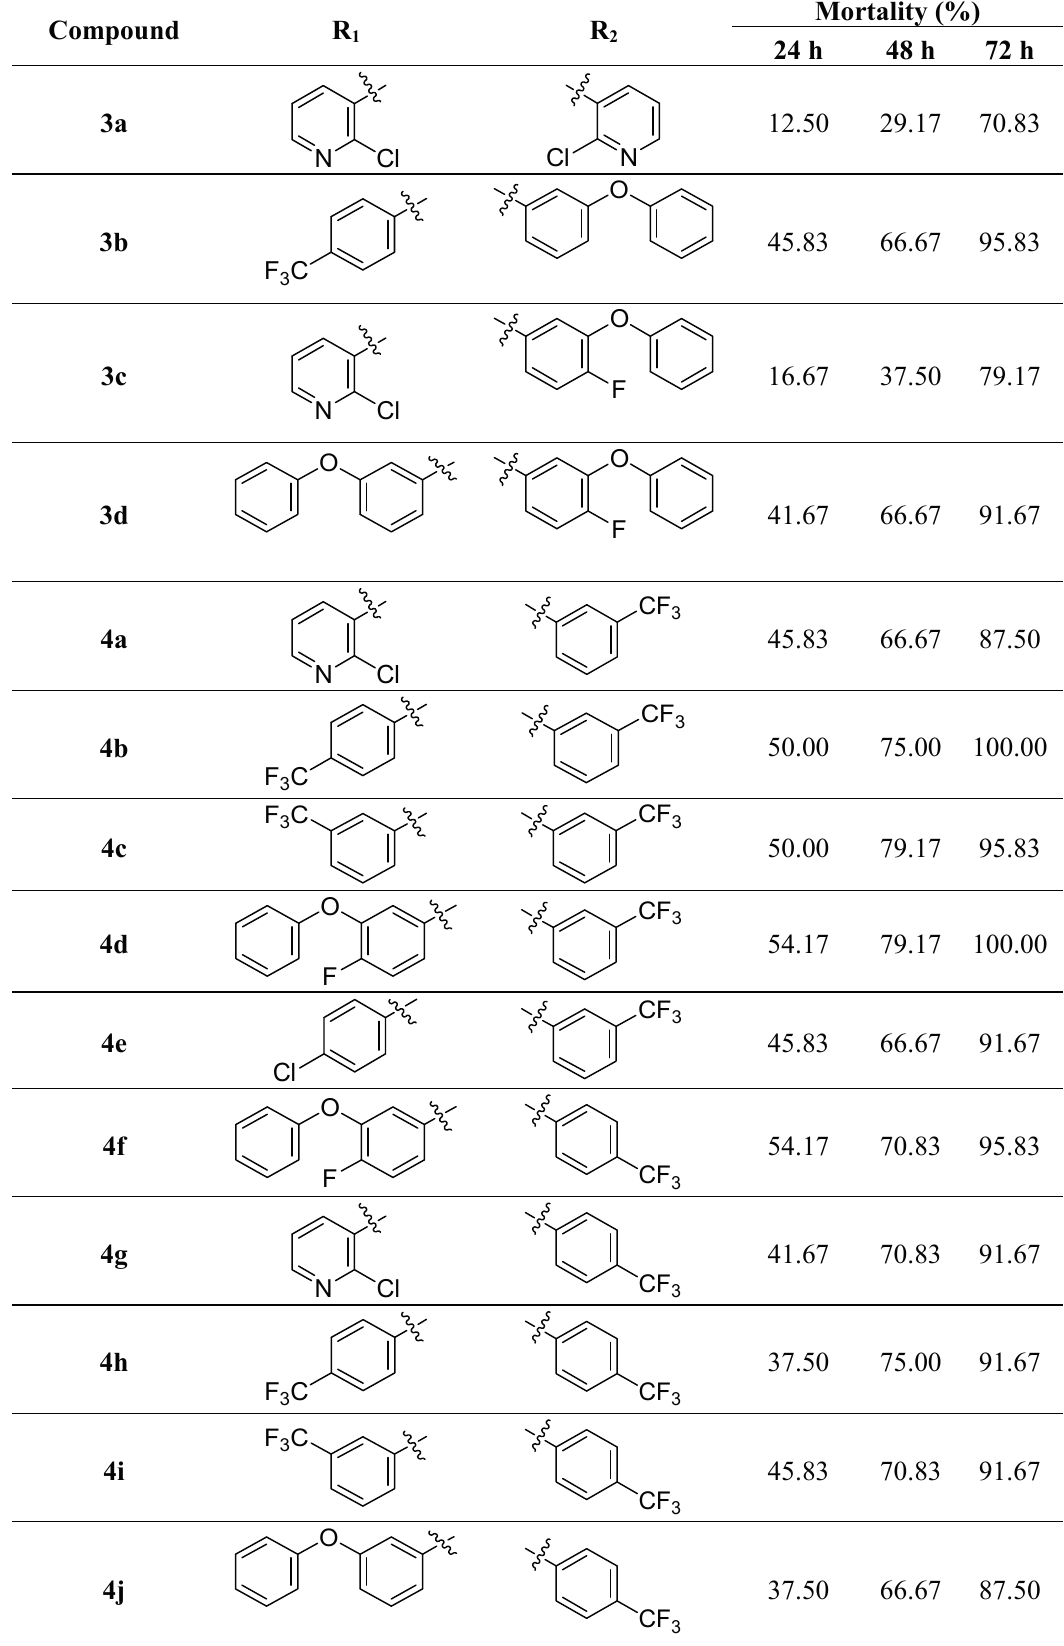
Table 1. Insecticidal activities of diacylhydrazine and acylhydrazone derivatives (concentration, 10 mg/L) against the third instar larvae of beet armyworm.